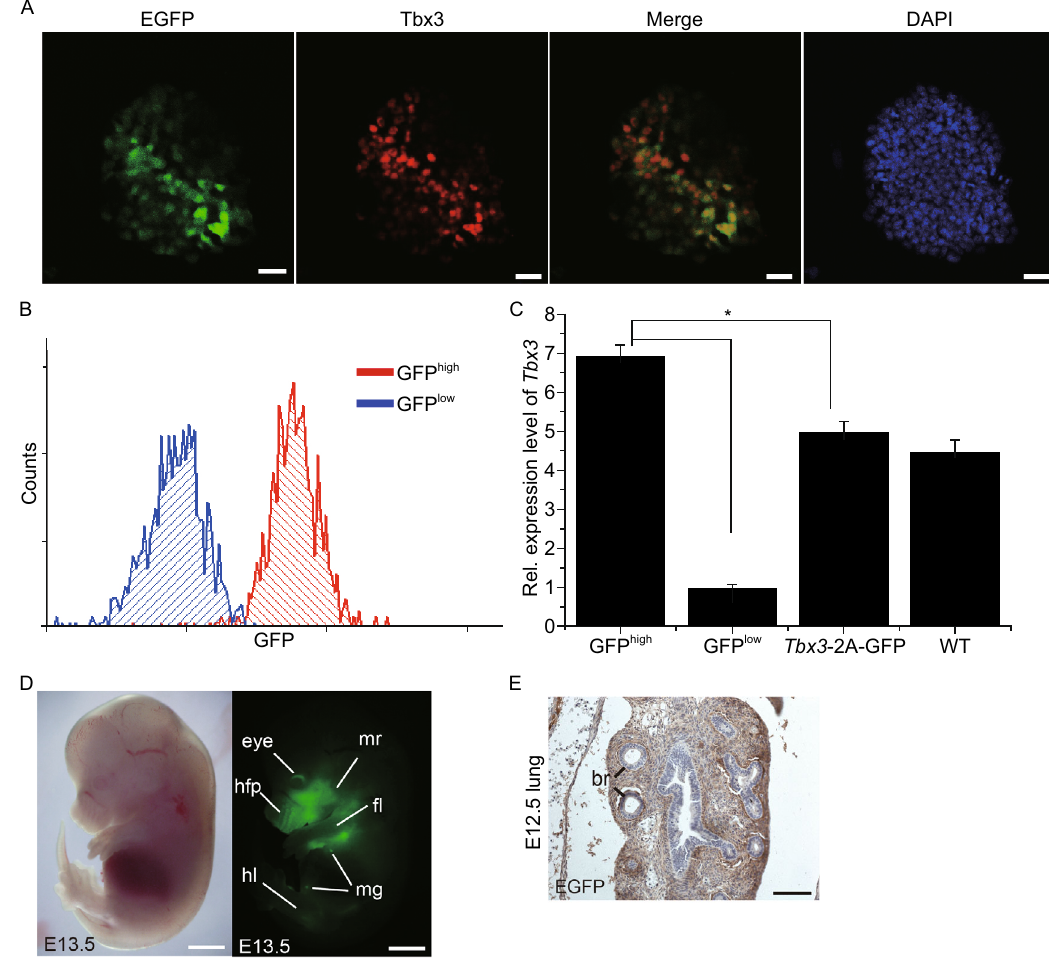
Figure 2. Both Tbx3-2A-GFP mice and ESCs can be used for phenotypic analysis directly . (A) The consistent expression pattern of GFP and Tbx3 in Tbx3-2A-GFP ESCs. Scale bars, 50 µm. (B) Tbx3-2A-GFP ESCs were sorted into two subpopulations based on the fl uorescence intensity of GFP. (C) The expression levels of Tbx3 in two subpopulations were quanti fi ed by RT-PCR. (D) Phase contrast images (left) and corresponding GFP fl uorescence images (right) of early embryos and tissues from Tbx3 -2A-GFP mice. fl , forelimb; hl, hindlimb; ml, milk line; mr, mandibular and maxillary region; mg, mammary gland; hfp, hair follicle placodes. Scar bars: 1 mm. (E) Immunohistochemical detection of GFP in the section of lung from knock-in mice. br, bronchi. Scar bars, 50